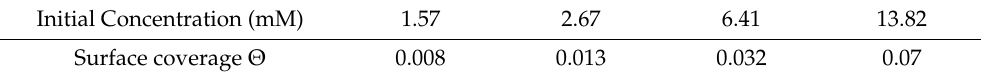
Table 1. Photocatalyst surface coverage as a function of initial ammonia